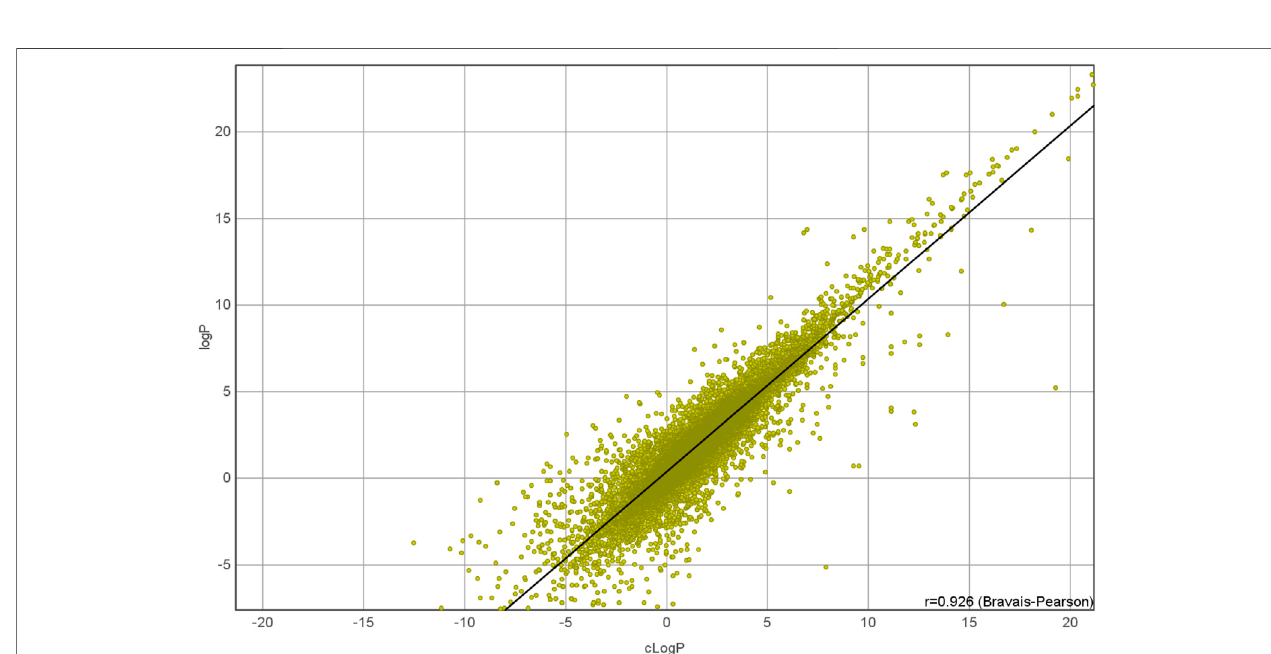
FIGURE 2 | Comparison of 25,000 experimental logP values with DataWarrior calculated logP.